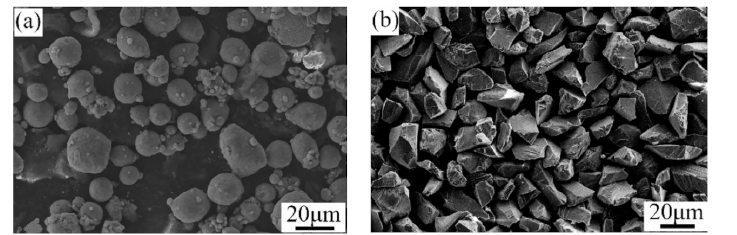
Figure 2. SEM morphologies of the ( a ) Al and ( b ) Al 2 O 3 powders.